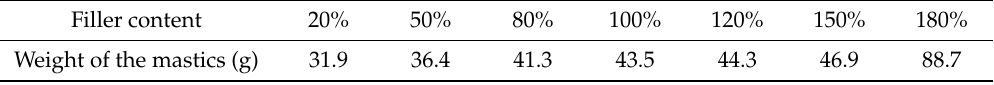
Table 2. The weight of the mastics with di ff erent filler contents in one plate. Filler